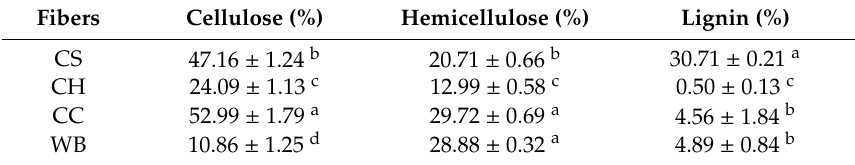
Table 3. Cellulose, hemicellulose, and lignin contents in natural lignocellulosic fibers (mean ± standard deviation). Fibers